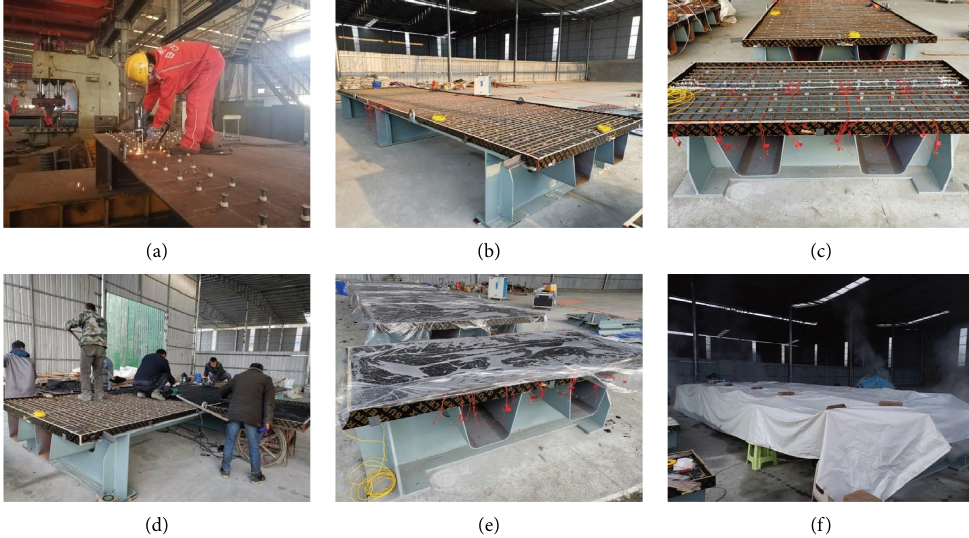
Figure 5: Details of specimen fabrication: (a) welding of OSD and studs; (b) installation of rebars and formworks; (c) measuring point arrangement; (d) casting of UHPC; (e) air curing; and (f) steam